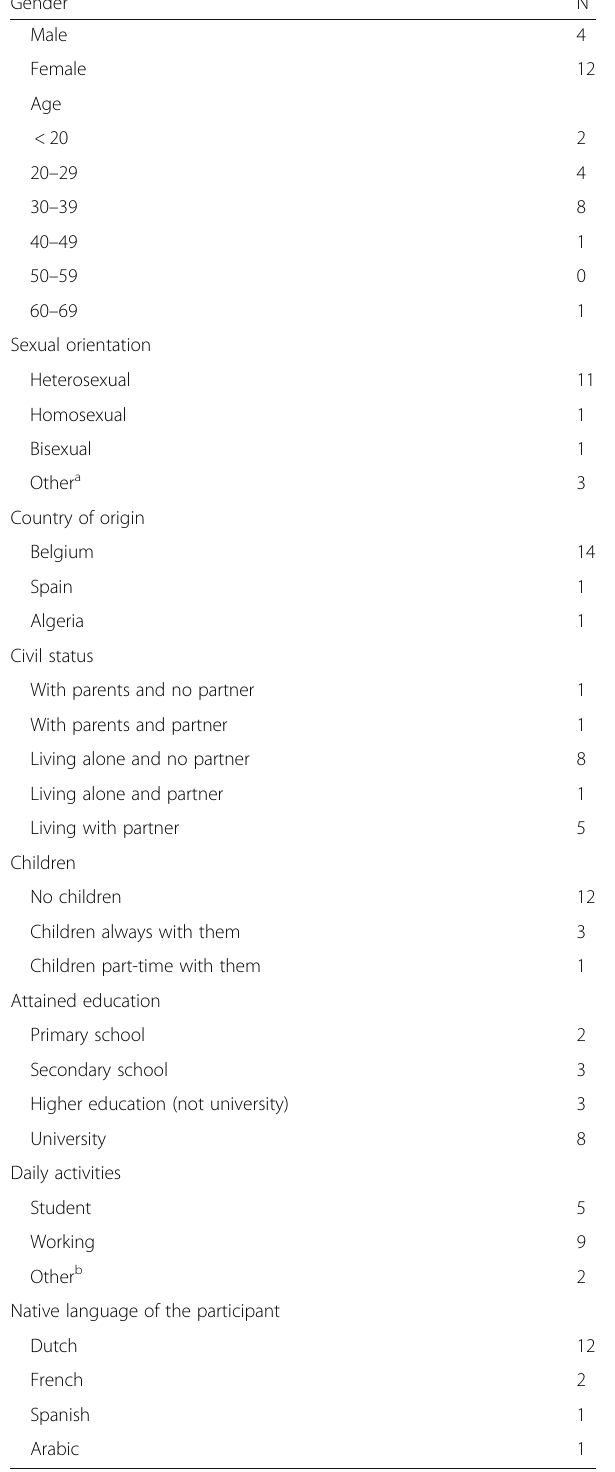
Table 1 Profile of participants ( N =